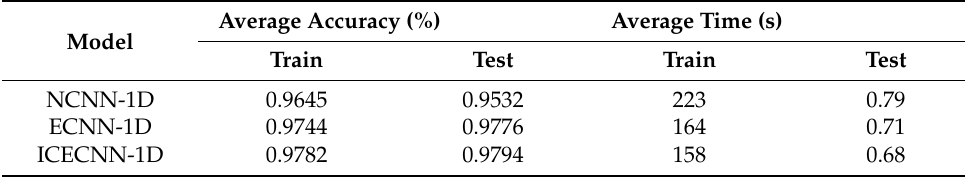
Table 3. Experimental comparison results of NCNN-1D and